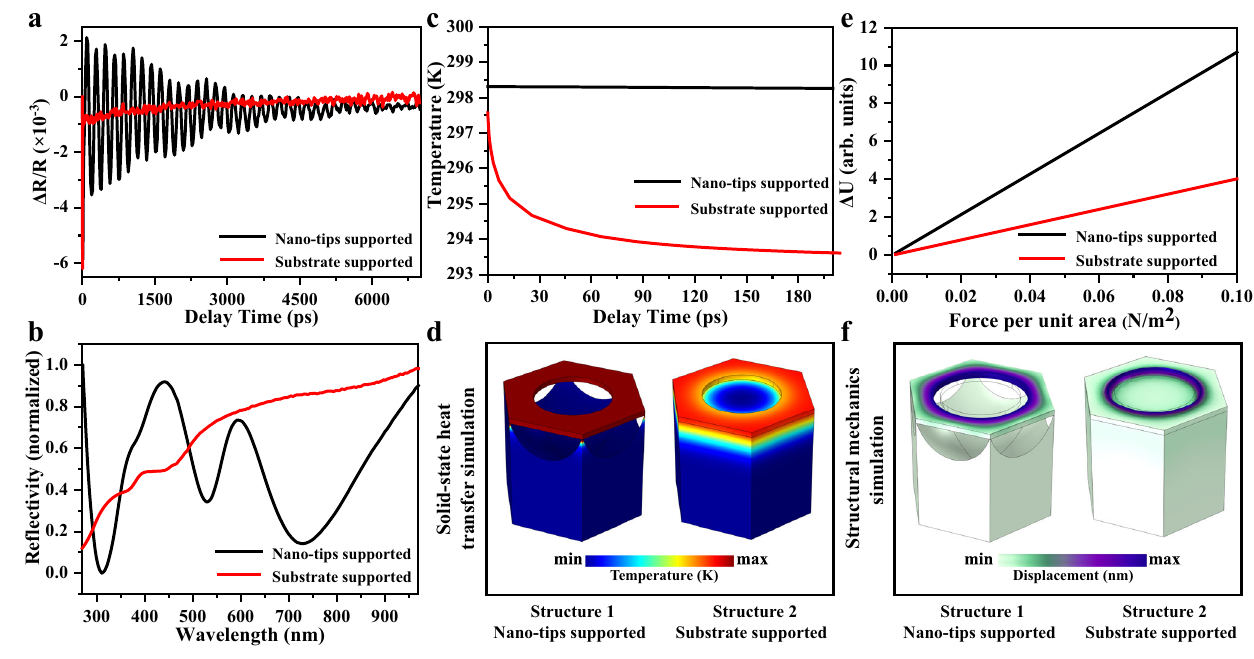
Fig. 3 | Transient and steady-state optical measurements and thermal, mechanical simulations. a Transient re fl ection spectra of the optomechanical metasurface supported on a monocrystalline silicon substrate and the silicon nanotip arrays. b Optical re fl ectance spectra of the optomechanical metasurface